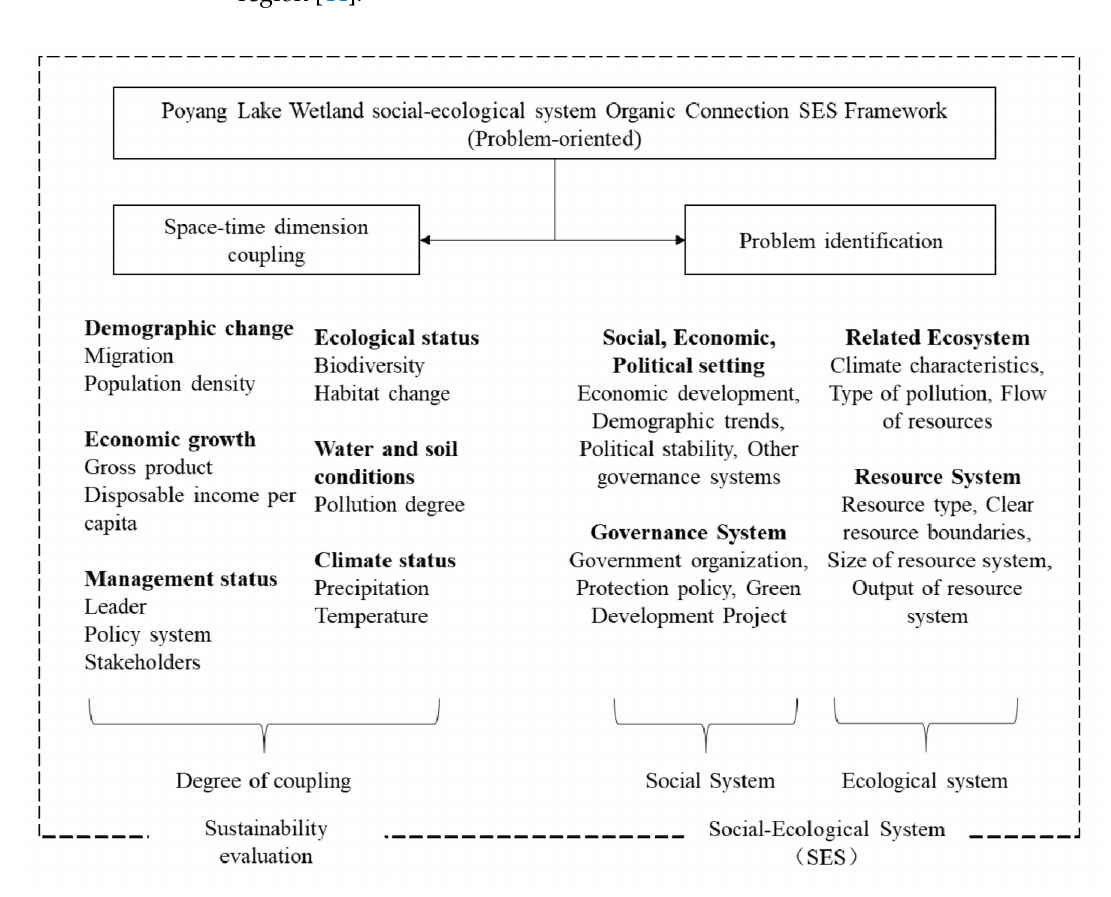
Figure 4. Problem-oriented social-ecological system (SES) dynamic analysis